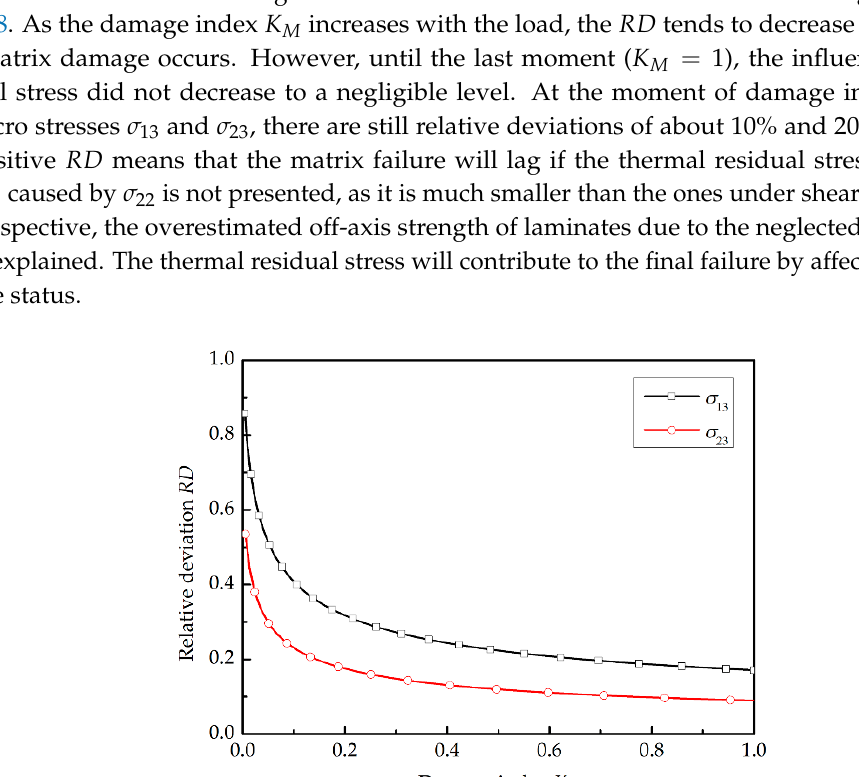
Figure 8. The relative deviation-damage index curve under macro stress σ 13 and σ 23